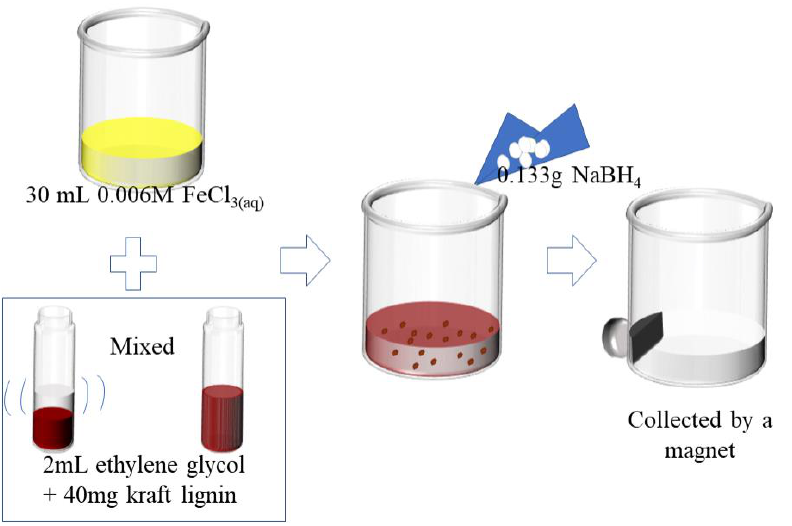
Figure 1. Experimental procedure for the synthesis of nZVI/n-lignin composite